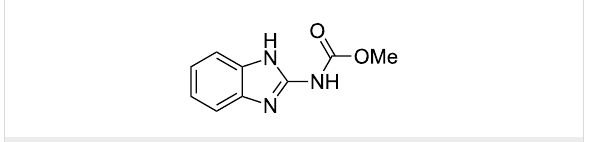
Figure 1: Chemical structure of